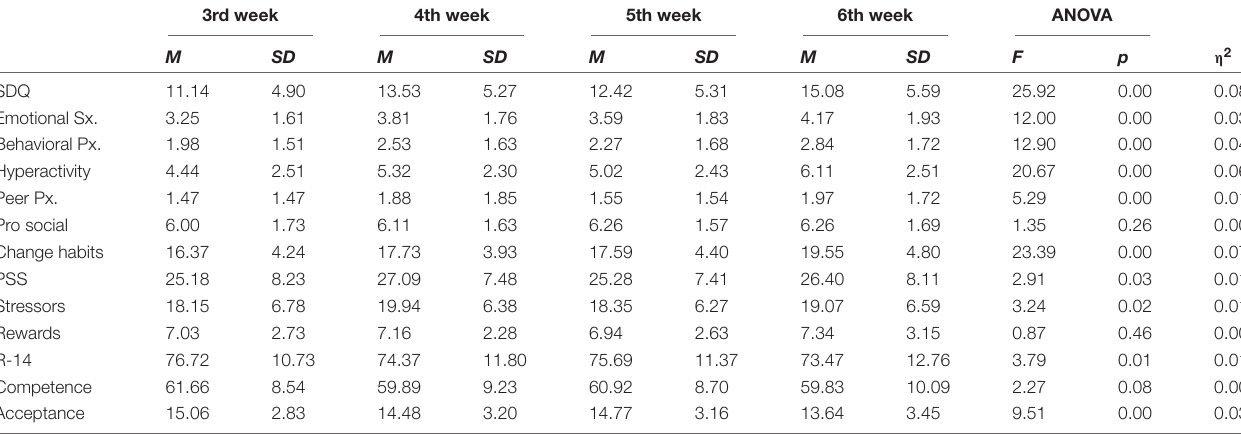
TABLE 3 | Mean scores, standard deviation and differences in points of